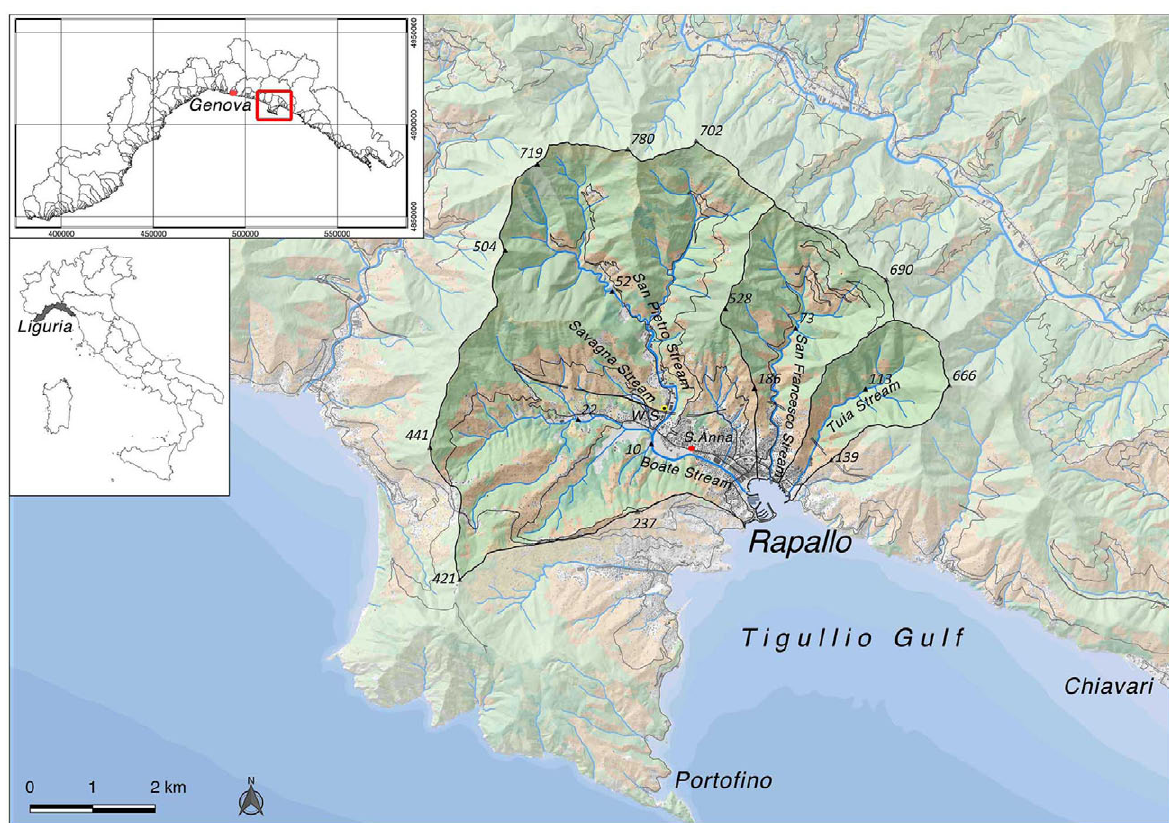
Fig. 1. Location map of the study area (W.S.: S. Pietro weather